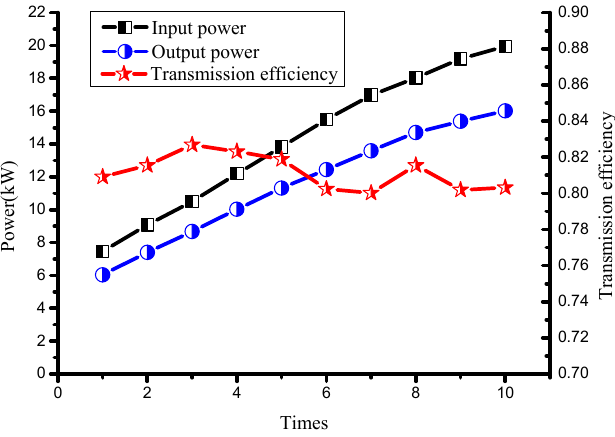
Figure 17. The power and the transmission efficiency.